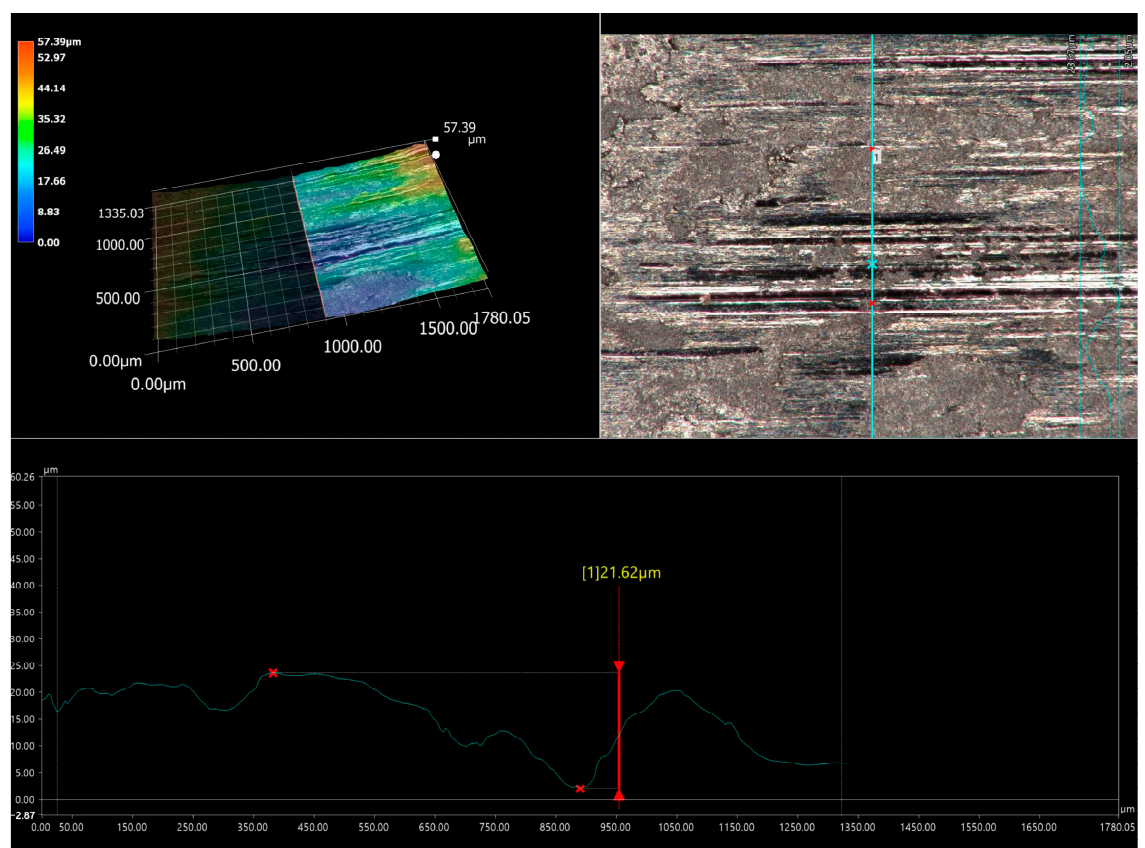
Figure 19. The cross-section of the 3D image of the surface topography and the 2D pro fi le across the worn track formed on the surface of the counter-specimen mating with specimen laser-alloyed with a laser beam power of 1.3 kW; 1—measuring point of the depth of the worn track in relation to the nominal surface of the counter-specimen.